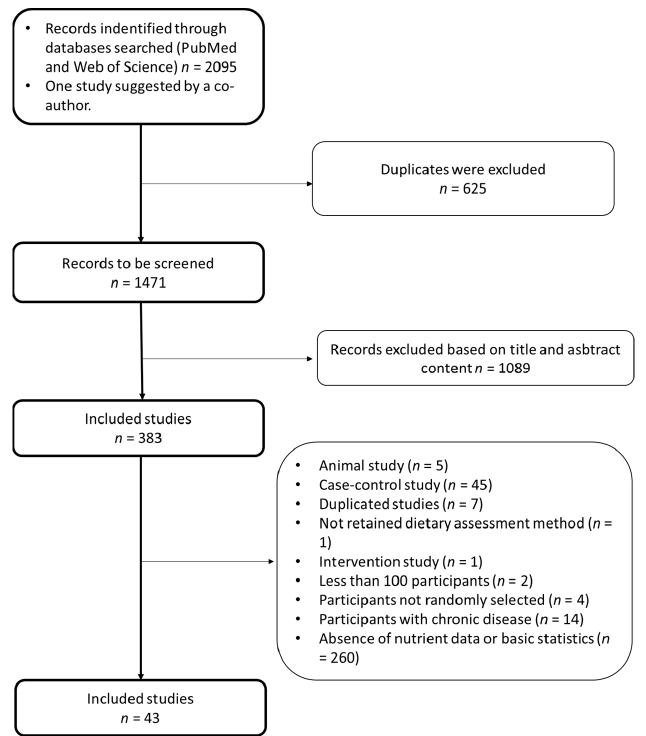
Figure 1. QUORUM: Micro ‐ and macro ‐ nutrient intake among adults in the Eastern Mediterranean Region: a meta ‐ analysis. The overall study characteristics are displayed in Table 2 [21–61]. Iran was the most represented country ( n = 55,592, 76.6%). The mean age was 37.5 ± 8.7 years and women were predominant, with a gender ‐ ratio of men:women of 0.7. Some studies included older subjects, such as Abshirini et al. [21] and Benhammou et al. [51], where the mean age was 56 years and 42 years, respectively. Table 2. Socio ‐ demographic characteristics of studies included in the systematic review [21–62]. Country Study